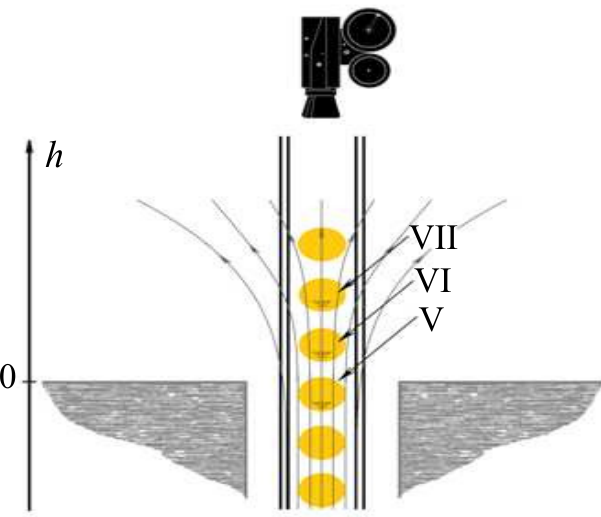
Figure 1. Sketch of the upper part of the experimental setup. A stratified glow discharge is ignited in the tube inside the solenoid. We observe dust structure rotation in the striations V, VI and VII near the upper end of the solenoid. They are shown at the bottom of these striations.